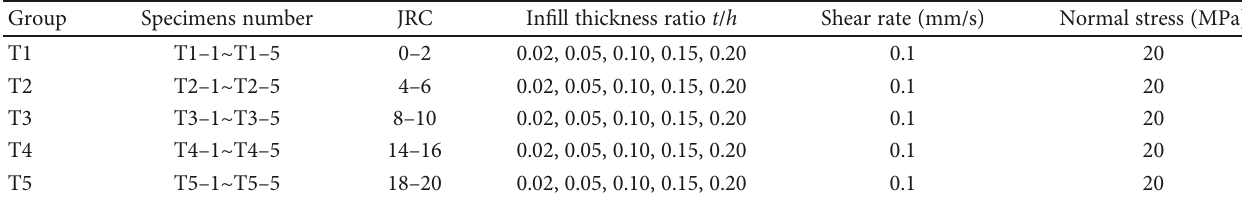
Figure 3: Simulation design and distribution of in fi ll pro fi les with di ff erent joint rough coe ffi cients (JRCs). (a) The height and width of the simulated specimens are 40 mm and 60mm, respectively. The upper half of the specimen moved to the right at a constant shear rate, while the lower part was con fi ned by the servo-controlled wall to maintain the constant normal stress. (b) Pro fi les of the employed JRCs. Table 2: Simulation parameters.